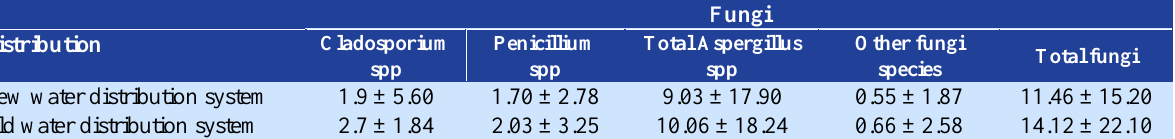
Table 2. Average concentration of fungi (number/100ml), measured in old and new water distribution System